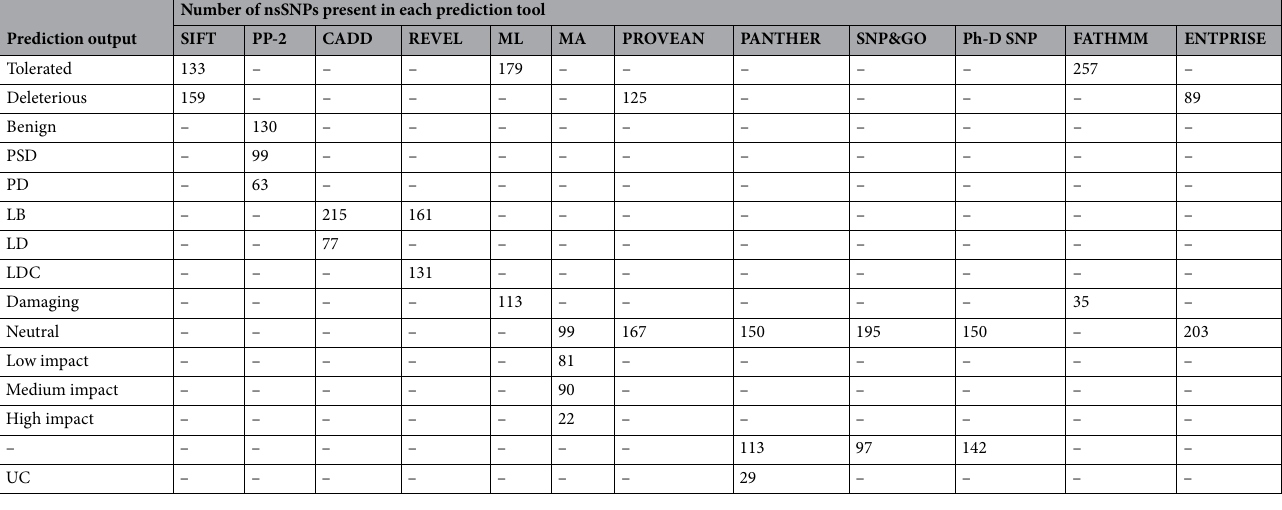
Table 1. Summary of initial sequence based screening of 292 nsSNPs by twelve sequence based prediction tools. Number of nsSNPs shown for each category. PSD possibly damaging, PD probably damaging, LB